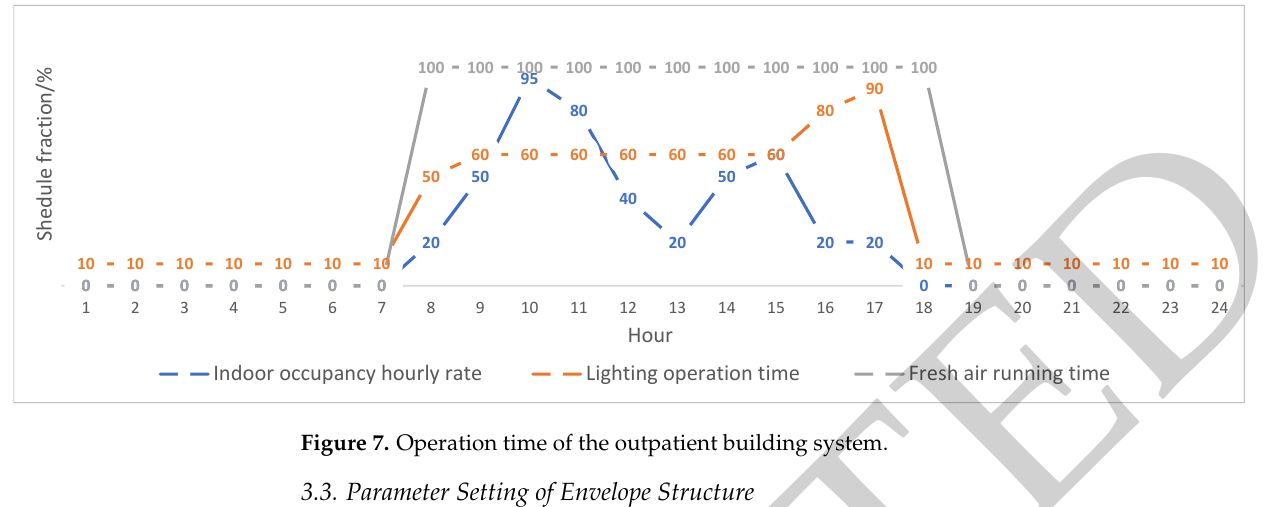
Figure 7. Operation time of the outpatient building system.